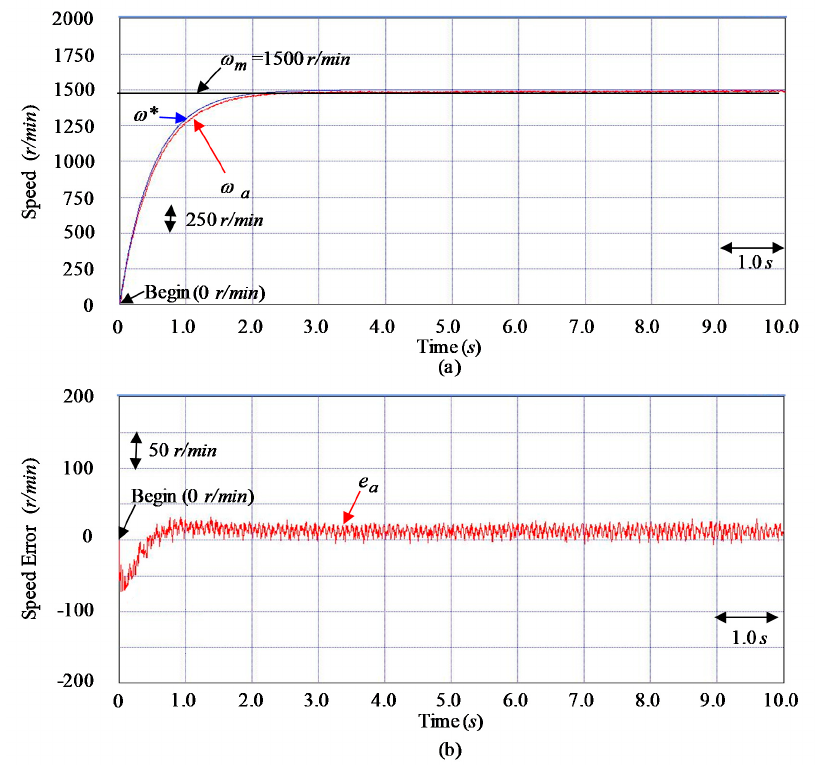
Figure 9. Tested results for the SIM expelling CVT organized system at the tested Event E1 case by using the controller CT2: ( a ) speed response, ( b ) speed discrepancy response.